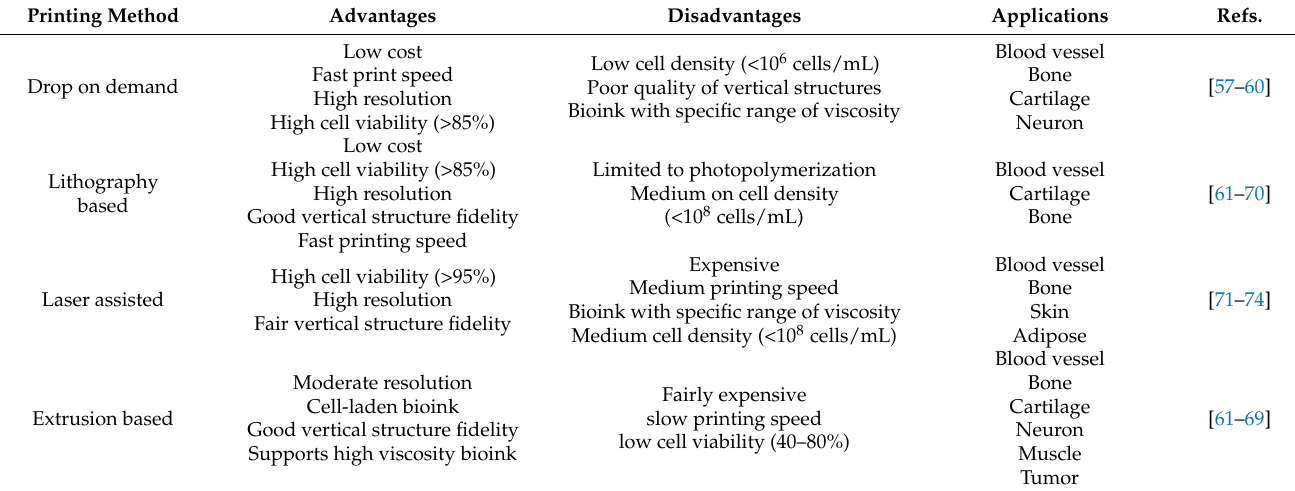
Table 2. Comparison of four types of bioprinting methods. Combining information from